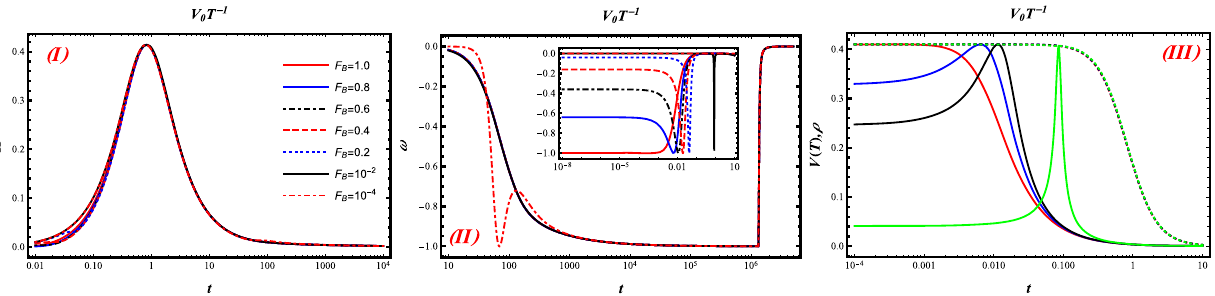
Fig. 2 Evolutions of H , ω , V ( T ) and ρ for different initial conditions for an inverse-power potential with n = − 1. The initial conditions for plots I and II are shown in I. Plot III is of V ( T ) (solid) and ρ (dotted) for the initial conditions F B = 1 (red), F B = 0 . 8 (blue), F B = 0 . 6 (black), and F B = 0 . 1 (green)